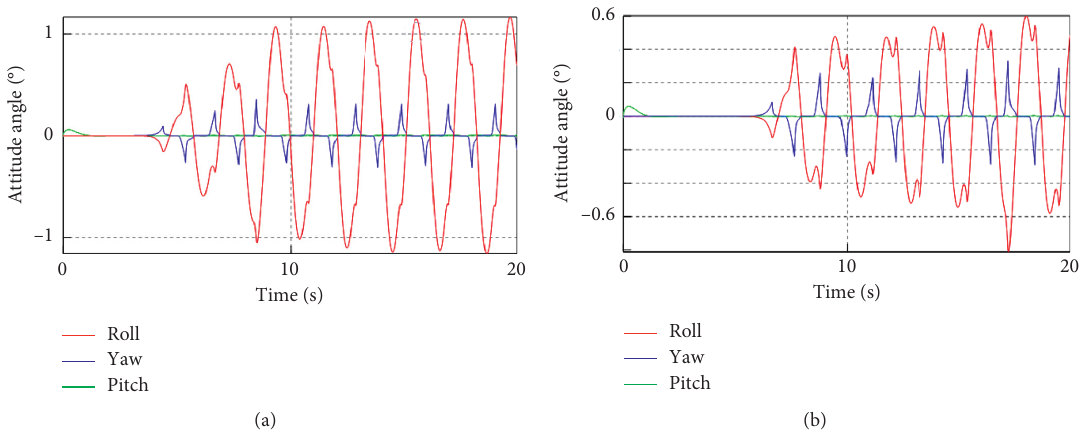
Figure 20: Changes of the attitude angle under different supporting wheel treads: (a) 322mm and (b) 522 mm.